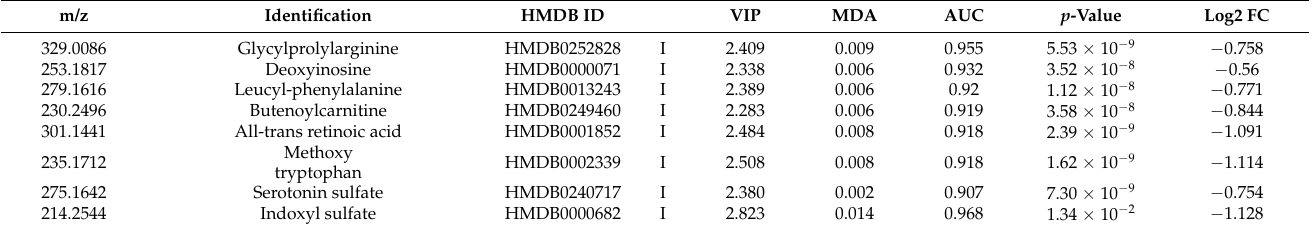
Table 3. The m/z values for the most signi fi cant metabolites from urine samples and their identi fi - cation according to the HMDB database. These metabolites were considered predictive given their VIP and MDA values.